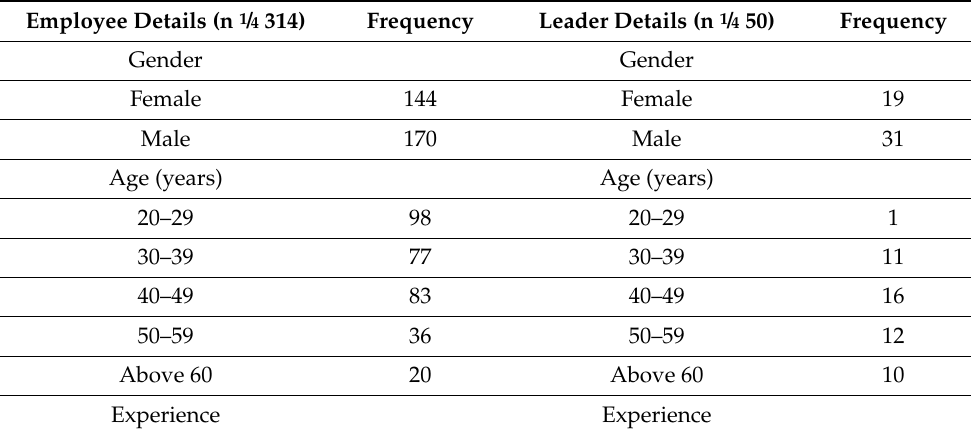
Table 1. Respondent